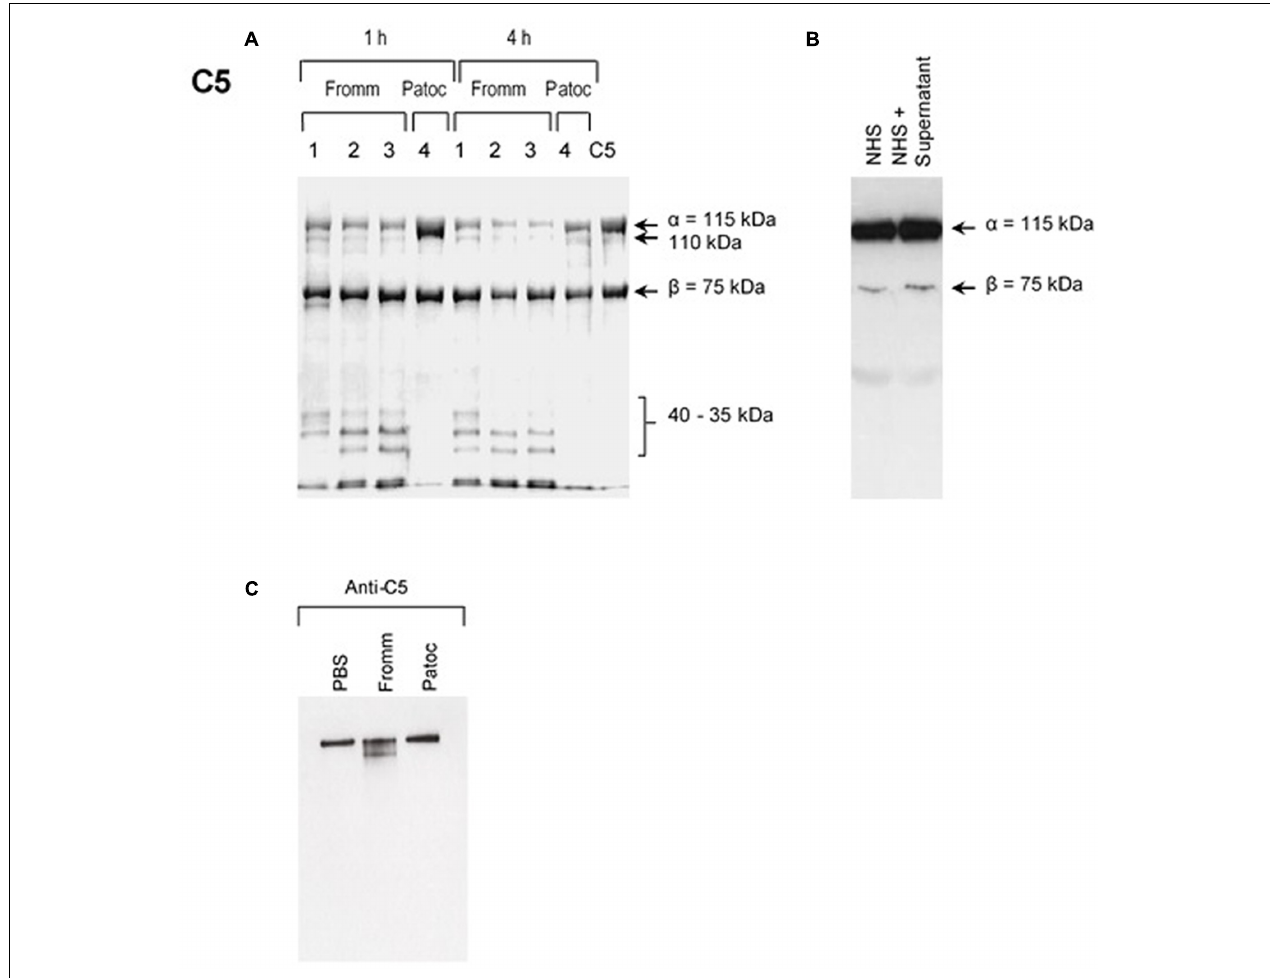
FIGURE 1 | Supernatants of pathogenic (SPL) proteases cleave purified component C5 and C5b from the MAC. (A) Different concentrations (1) 0.6 µ g; (2); 0.12 µ g; (3) 0.06 µ g of SPL from Leptospira interrogans serovar Kennewicki strain Fromm or (4) 0.06 µ g SNPL from L. interrogans serovar Patoc strain Patoc I were incubated with 3 µ g of purified C5 (left) for 1 or 4 h at 37 ◦ C. (B) Alternatively, SPL was incubated with 10% normal human serum (NHS) for 1 h at 37 ◦ C (right). The cleavage products were separated after SDS-PAGE and analyzed by Western blot using polyclonal anti-human C5. (C) SPL (Fromm) and SNPL (Patoc) were incubated with 5 µ g of purified SC5b-9 complex for 4 h at 37 ◦ C. The cleavage product was analyzed by under non-reducing conditions by Western blot using polyclonal anti-C5 antibody.